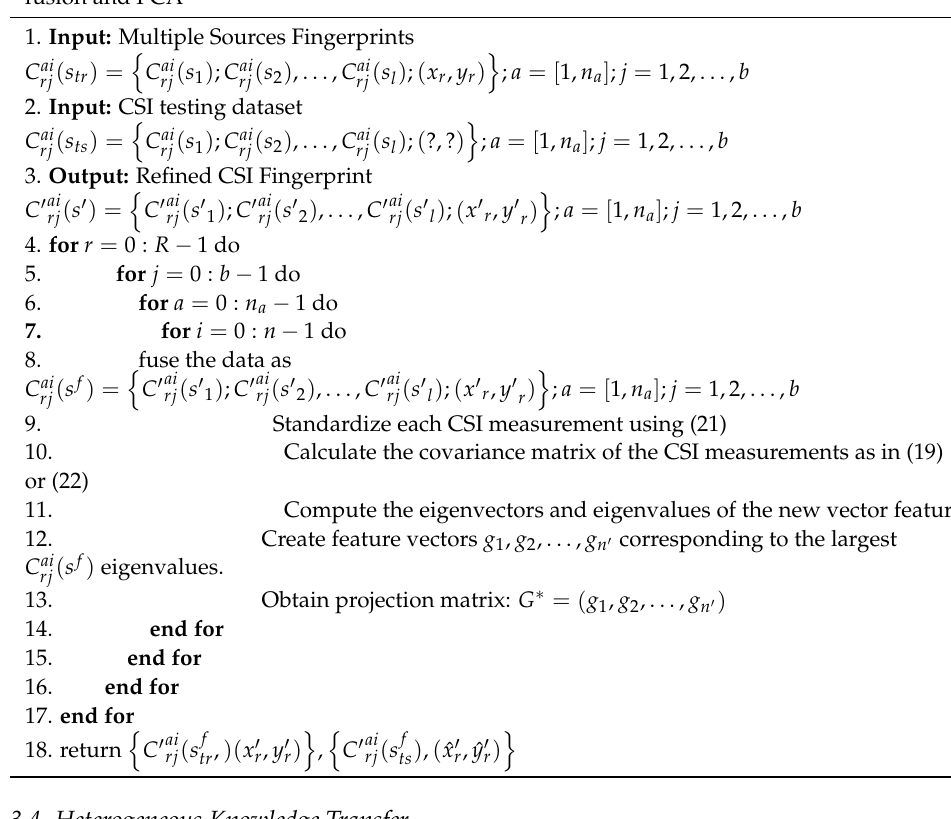
Algorithm 1 Construction of the new dimension of CSI fingerprint feature vectors-based data fusion and